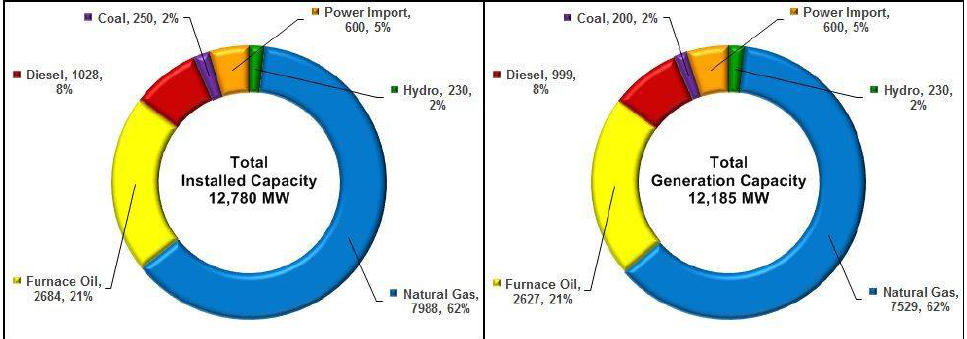
Figure 1. Total Installed Capacity and Total Generation Capacity of Bangladesh. Adapted from [28]. According to the Power System Master Plan (PSMP) 2010 [30], the forecasted demand for the power based on 7% GDP growth rate shows that only nuclear power plant can fulfill the demand requirement of the nation, as illustrated in Table 3. Table 3. Demand for the power based on 7% GDP [30].